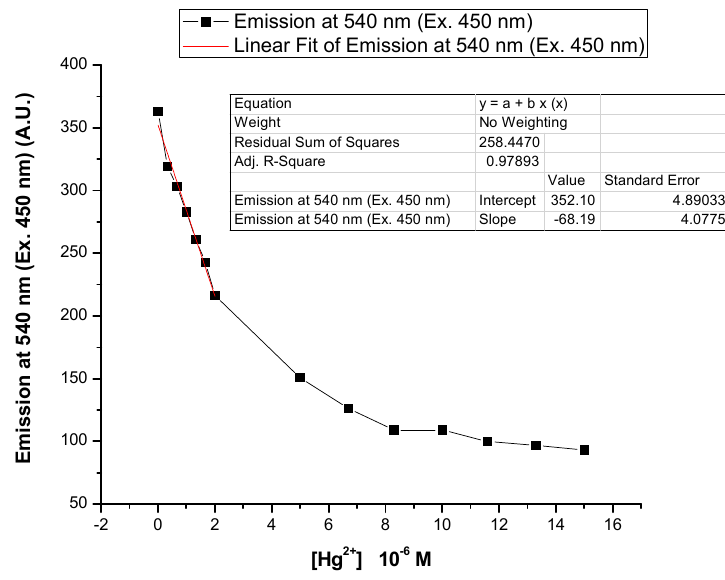
the slop of the titration plot. The found LOD was found to be 2 × 10 − 7 M.